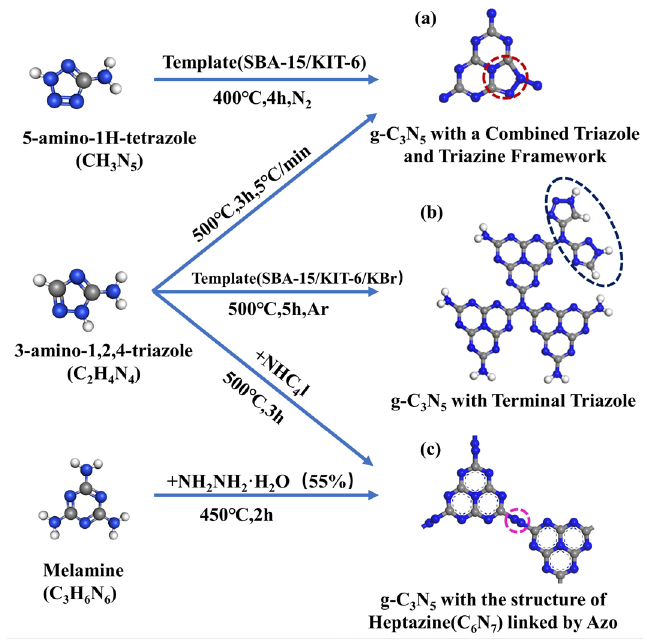
Figure 1. Schematic illustration of the g-C 3 N 5 synthesis process by the thermal polymerization of different precursors, such as 5-amino-1H-tetrazole, 3-amino-1,2,4-triazole, and melamine. ( a ) g-C 3 N 5 with triazine and triazole; ( b ) g-C 3 N 5 with terminal triazole; ( c ) g-C 3 N 5 with heptazine linked by azo.